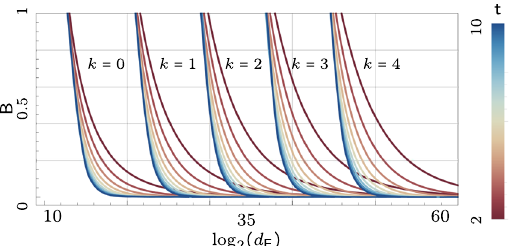
Fig. 3 Upper bound on the probability for non-Markovianity to exceed a small amount for processes with distinct number of interventions and design dynamics against environment size. Upper bound B , de fi ned by Eq.